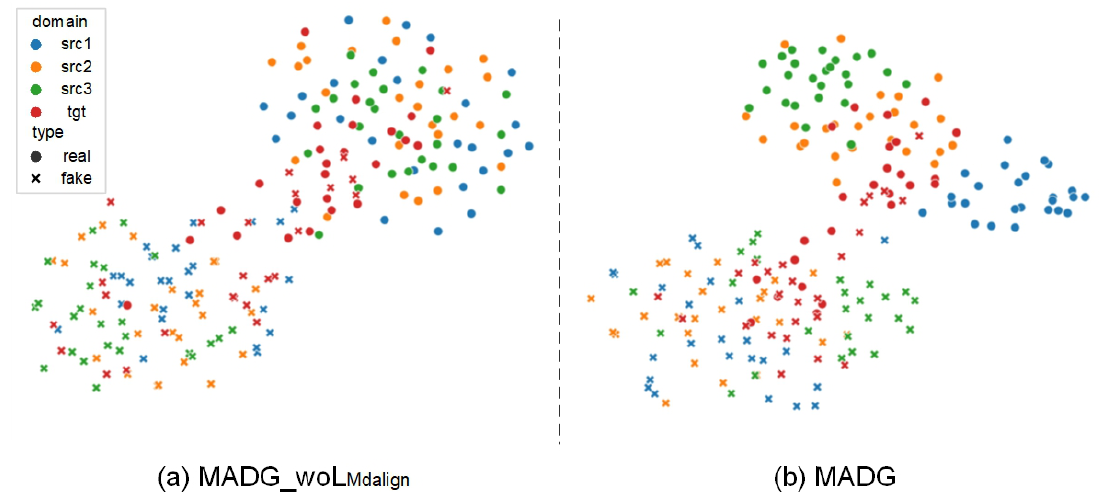
Figure 6. T-SNE visualization was employed to visualize the feature space of high-dimensional data, which enabled the exploration of the relationship between the input features and the output labels. In this study, we selected a subset of 200 samples to visualize the feature distribution. As shown in the scatter plot on the right, our proposed MADG method effectively learns discriminative features that enable clear separation between different domains. In contrast, the visualization of the ablation study, which excludes the multi-domain feature alignment module, exhibits a more disorganized feature distribution. By comparing the visualizations, we can infer that the proposed method achieves better generalization and is effective in aligning the feature distribution of real and fake faces across multiple